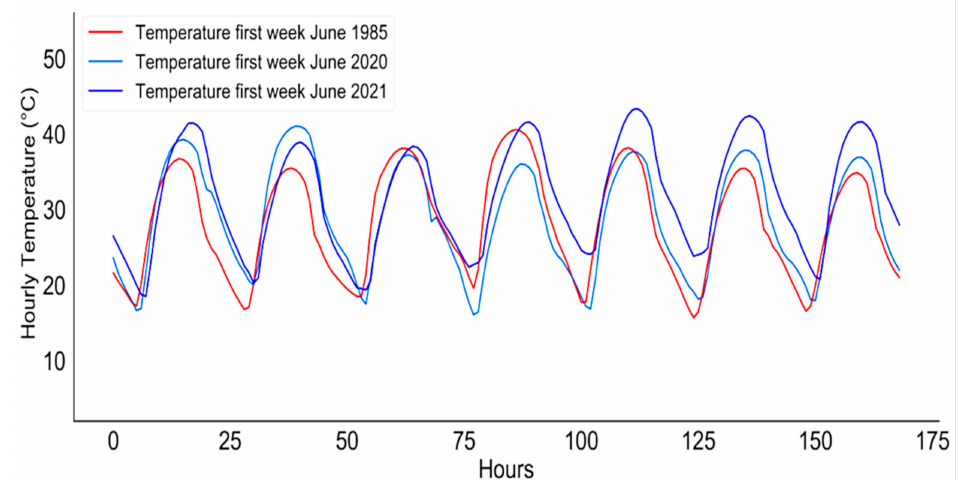
Figure 16. Hourly intervals historical performance of the temperature.